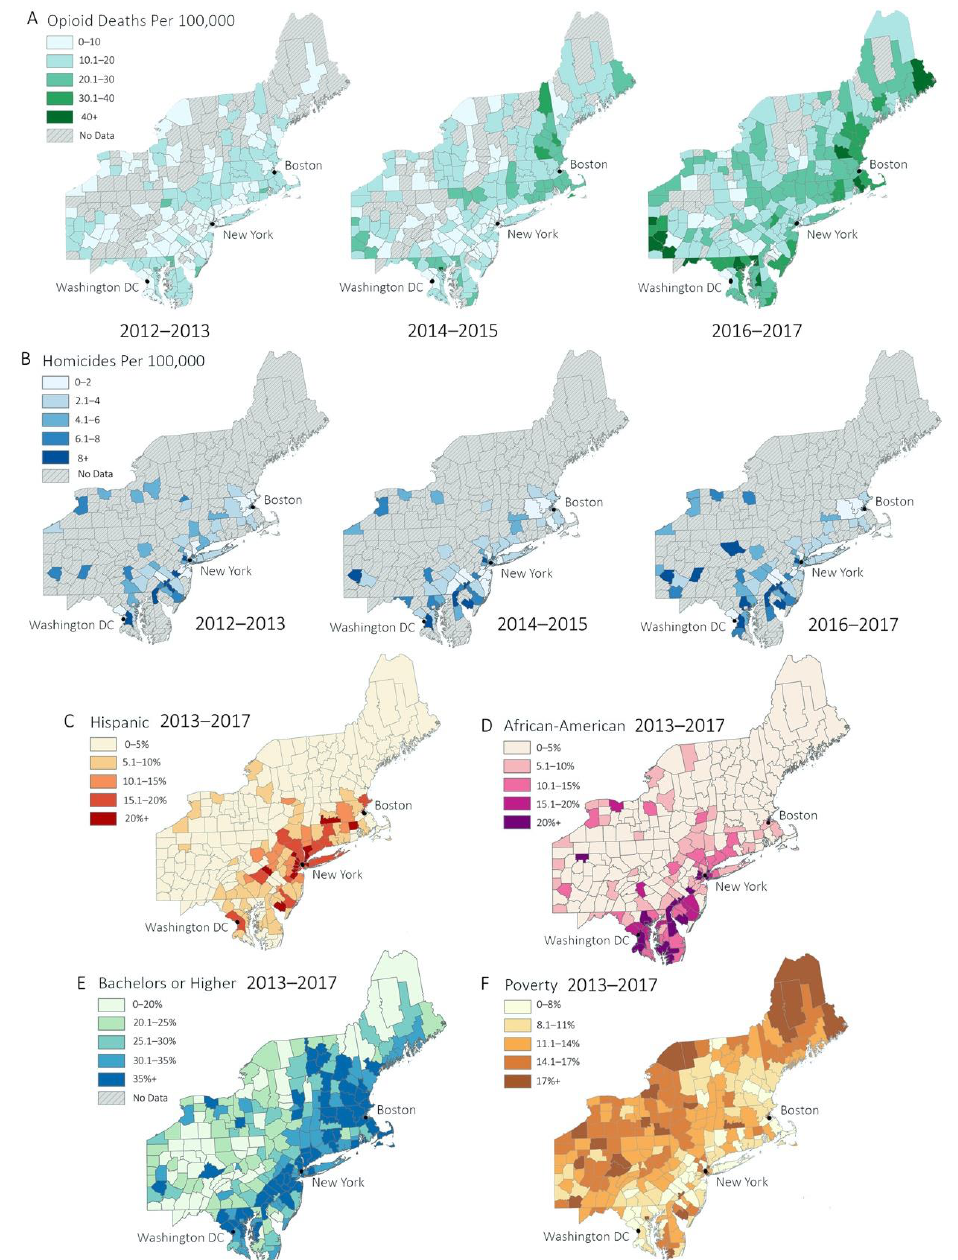
Figure 3. ( A , B ): Geographic distributions of independent variables over all time windows. ( A ) Opioid deaths per 100,000, ( B ) homicides per 100,000. ( C – F ): American Community Survey 5-year summary results from 2013–2017. ( C ) Percent of population Hispanic, ( D ) percent of population African American, ( E ) percent of individuals who have received a bachelor’s degree or higher, ( F ) percent of population living below the poverty line. Counties with no data were given a neutral (gray) color. Low rates of all variables are represented by lighter tones, while high rates are represented by darker tones.